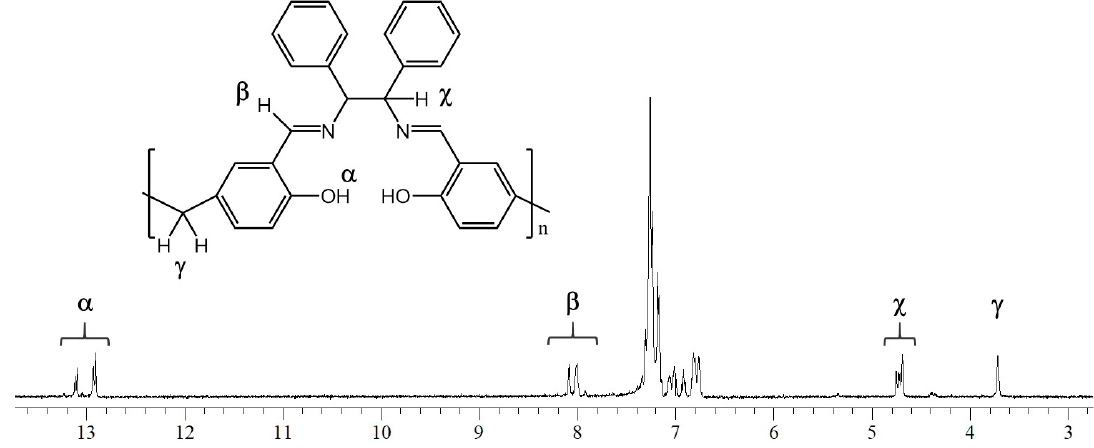
Figure 5. Representative 1 H NMR spectrum of the Oligo–Salen–B (reported in the inset) in CDCl 3.